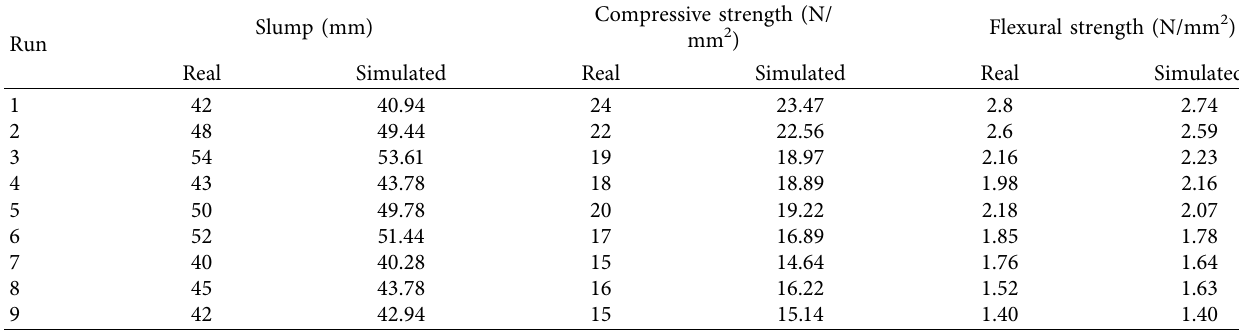
Table 3: Real and simulated values for response.